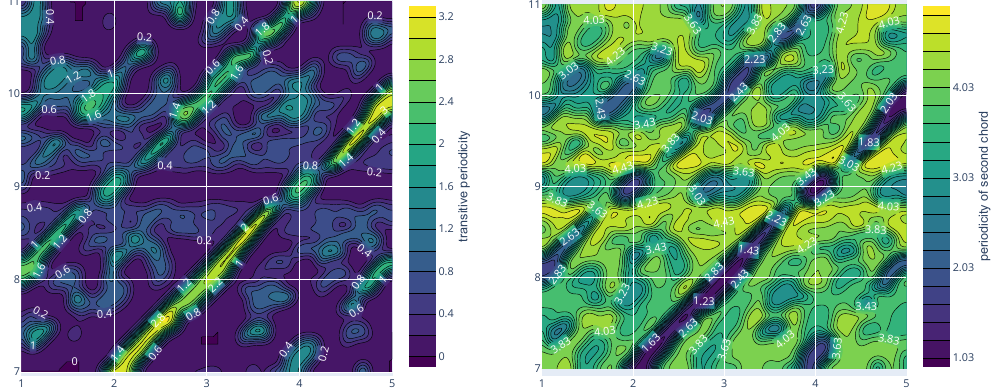
Figure 11. Contour plot for logarithmic transitive periodicities p ( c 1 → c 2 ) ( left ) with the correspond- ing logarithmic periodicities p c JND = 18 cent smoothed by a Gaussian with standard deviation σ = 6